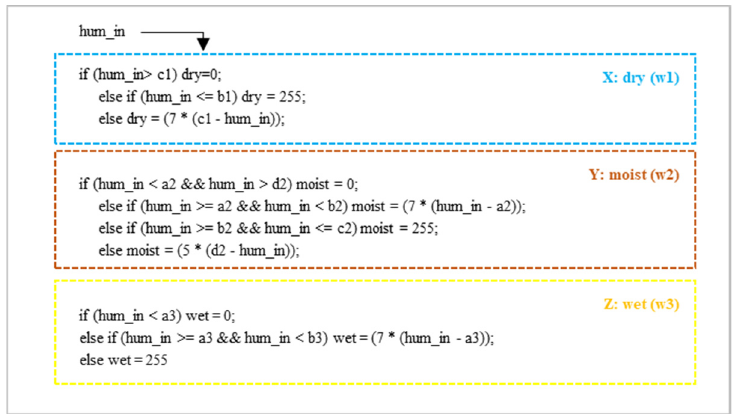
Figure 5. Representation of the algorithm for the fuz_dhl module corresponding to relative humidity (RH) fuzzification.